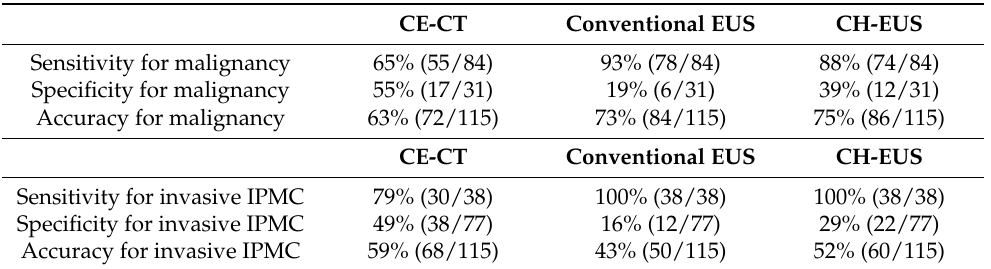
(Table 5, Figures 5–7). CE-CT, conventional EUS, and CH-EUS showed moderate accuracy for diagnosing invasive IPMC. Table 3. Diagnostic Abilities for Malignancy and Invasive IPMC According to the Presence of Mural Lesion on CE-CT, EUS, and CH-EUS.